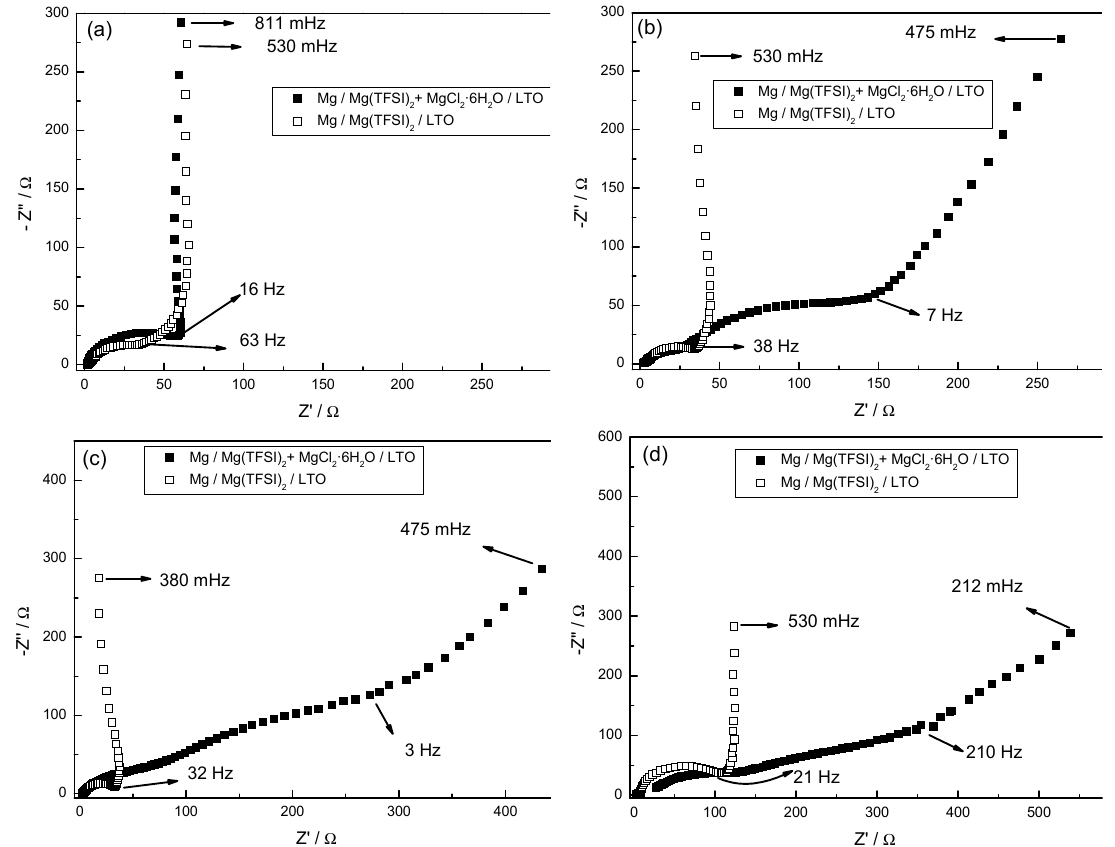
Figure 8. Nyquist plots of LTO electrode in Mg cells using two different electrolytes recorded at: ( a ) open circuit voltage (OCV), and after ( b ) first, ( c ) second and ( d ) fifth discharge. Rate: C/10. Note that the closed square symbols correspond to Mg/0.50 M Mg(TFSI) 2 + 0.13 M MgCl 2 · 6H 2 O in DME/LTO cell, while the open square symbols correspond to Mg/0.50 M Mg(TFSI) 2 in DME/LTO cell.